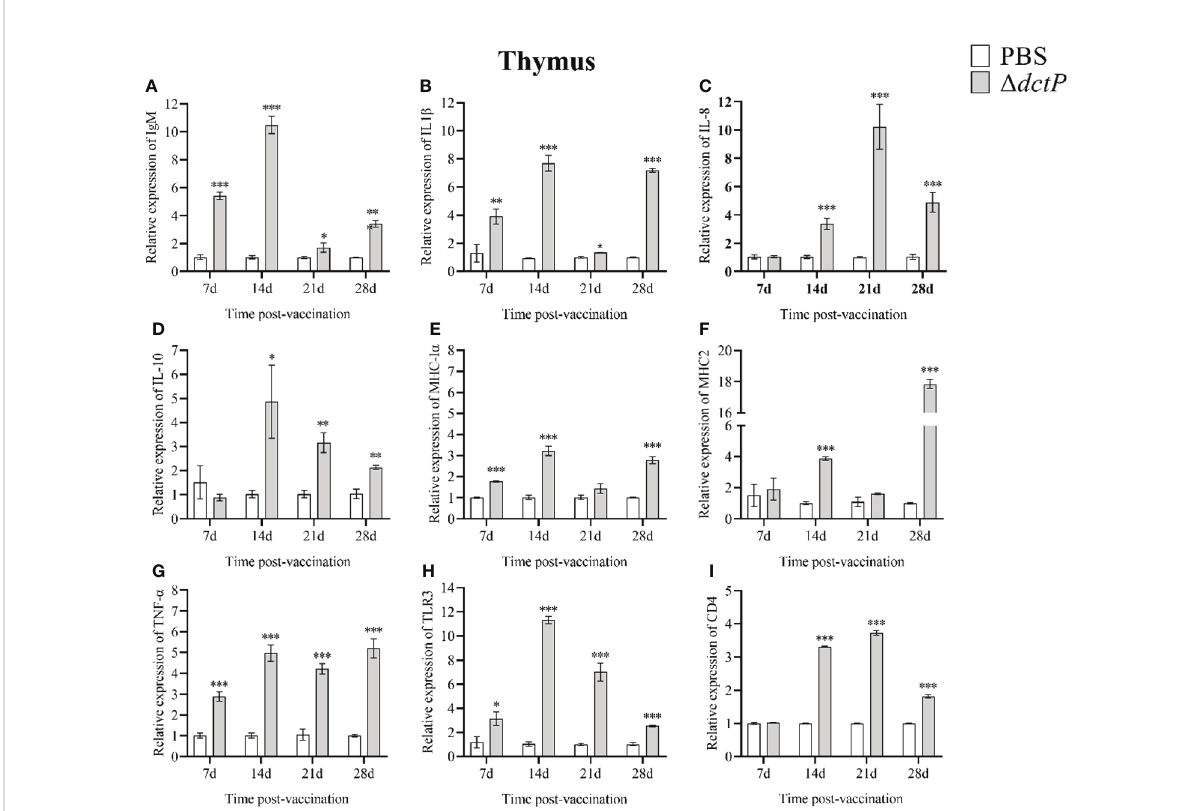
FIGURE 6 The expression levels of immune-related genes in the thymus of pearl gentian groupers by qRT-PCR post-immunization. The mRNA level of each immune-related gene was normalized to that of b -actin and relative expression was calculated as the values of the vaccinated tissues by those of the controls. (A) IgM , (B) IL-1 b , (C) IL-8 , (D) IL-10 , (E) MHC-I a , (F) MHC2 , (G) TNF- a , (H) TLR3 , and (I) CD4 . Bars represented the mean relative expression (n=3) and error bars represent standard errors. The asterisks indicated signi fi cant differences: *(p < 0.05), **(p < 0.01) and ***(p < 0.001), between PBS group and D dctP